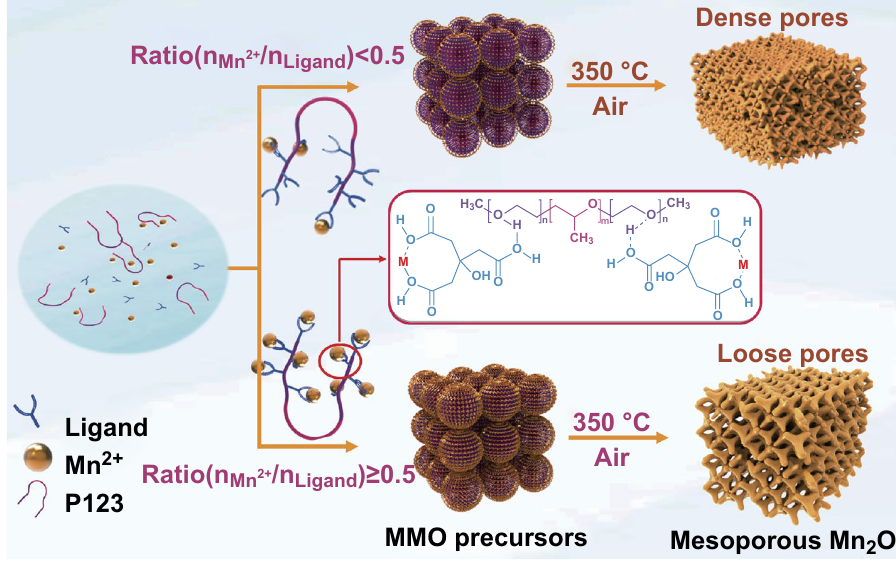
Fig. 1 Schematic illustration of the formation process for mesoporous Mn 2 O